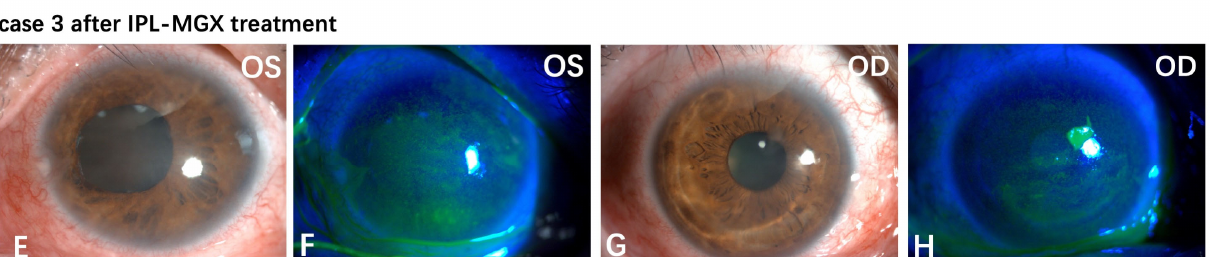
Figure 6. Case 11 in the IPL ‐ MGX group exhibited considerable improvement in the ocular surface condition from baseline to last follow ‐ up assessment. Images of the ocular surface and corneal flu ‐ orescein staining of both eyes at baseline ( A – D ) and during the last follow ‐ up visit ( E – H ). 4. Discussion SS is a chronic, currently incurable, and potentially deadly disease. Cell ‐ mediated immunity plays an important role in the pathogenesis of SS ‐ DE [3]. Although it is tradi ‐ tionally classified as aqueous tear ‐ deficient DE, mounting evidence suggests that ocular surface inflammation is not limited to the lacrimal glands [21]. An inflammation cascade is initiated on the ocular surface by lymphocytic infiltration and the increase in cellular